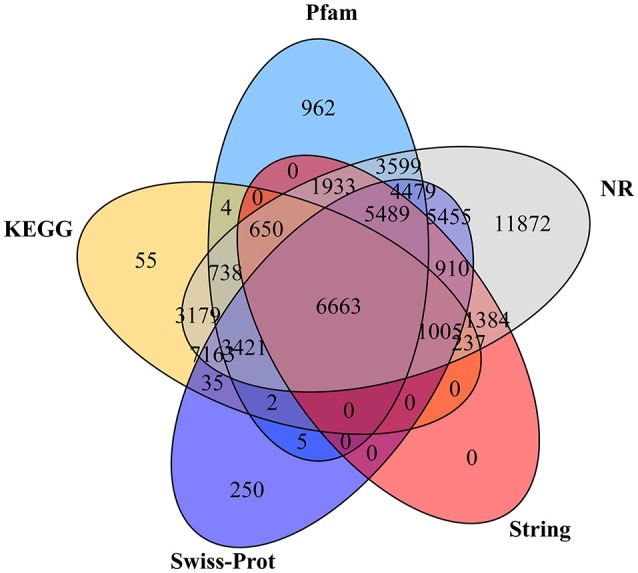
The Venn diagram shows the number of assembled unigenes annotated in five different public protein databases. The numbers in the circles indicate the number of unigenes annotated by single or multiple databases.